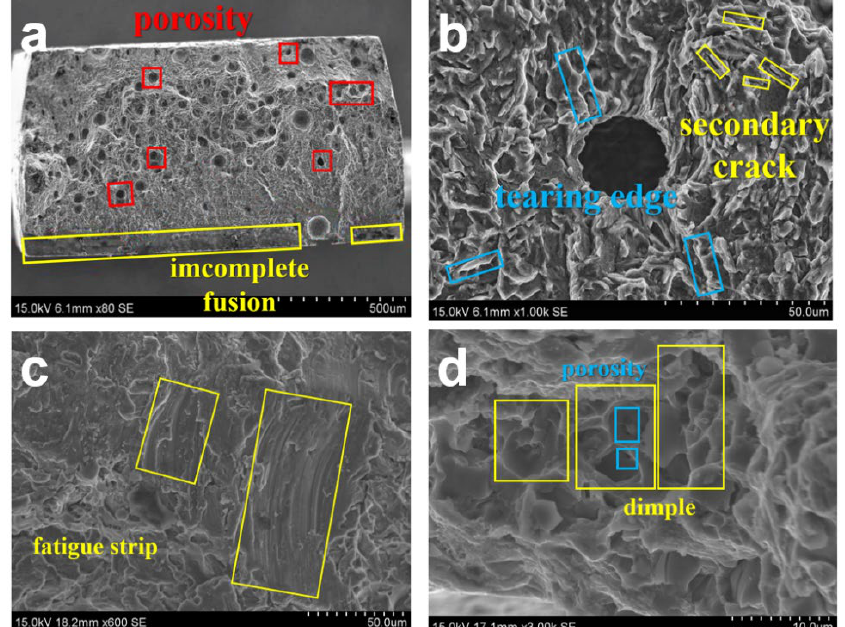
Figure 13. Fatigue fracture micromorphology: ( a ) fatigue fracture source; ( b ) secondary cracks and tearing edges; ( c ) fatigue strip ( d ) dimple and porosity.